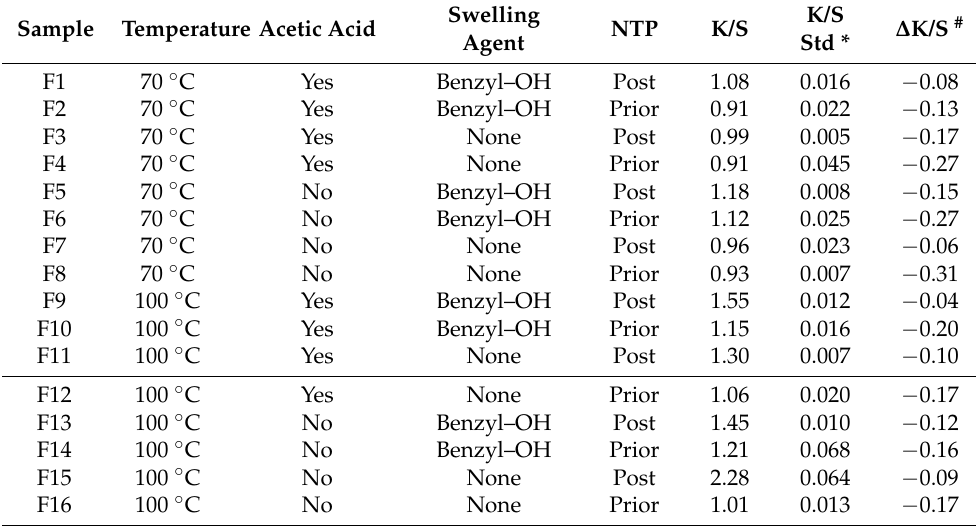
Table 5. Experiment F: experimental design and the results @ .